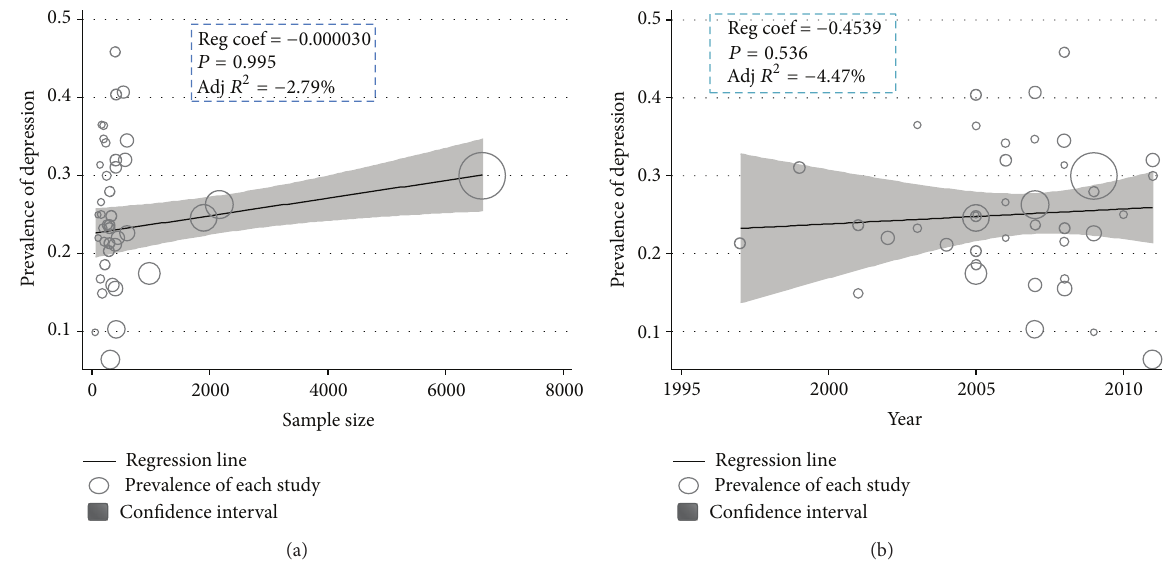
Figure 4: Metaregression plots of change in PPD according to changes in continuous study moderator’s year and sample size.